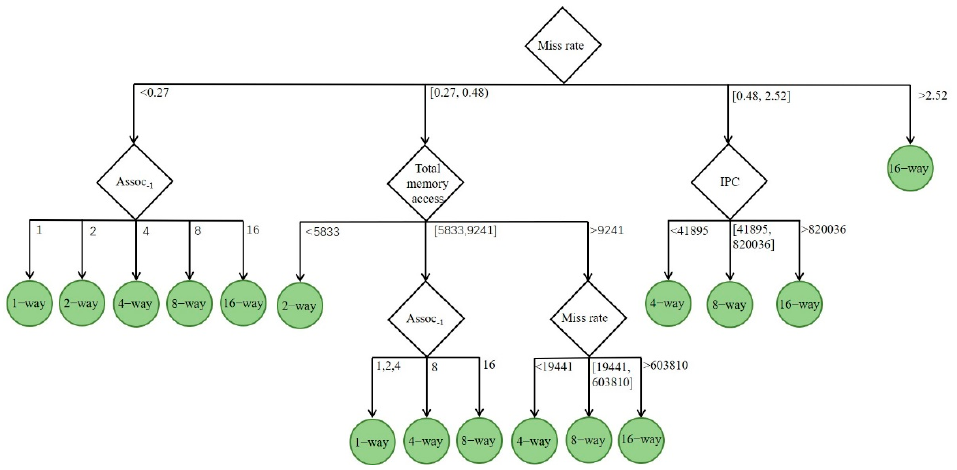
Figure 4. Decision tree model.